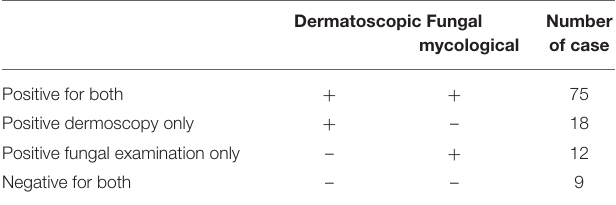
TABLE 3 | Dermatoscopic and fungal mycological results.